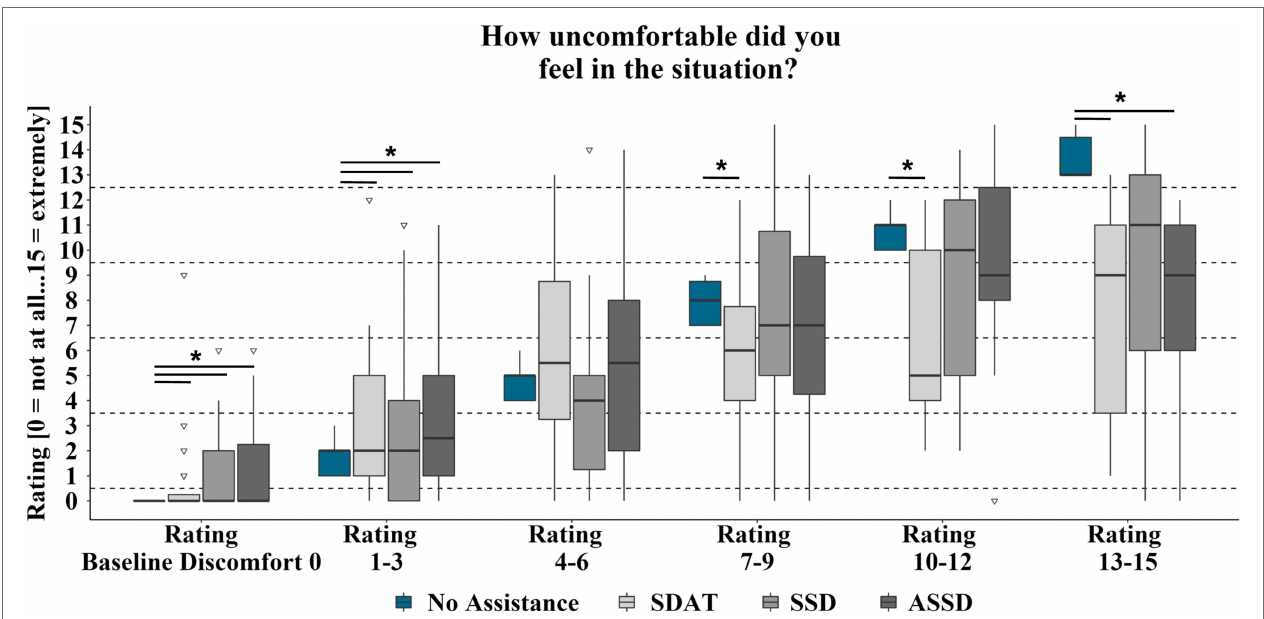
FIGURE 6 | Discomfort ratings for rides with and without assistance by discomfort ratings in the baseline ride. Significant ( p < 0.05) differences between ratings with and without assistance system are marked with * . Box range = Q1 to Q3. Whiskers = 1.5